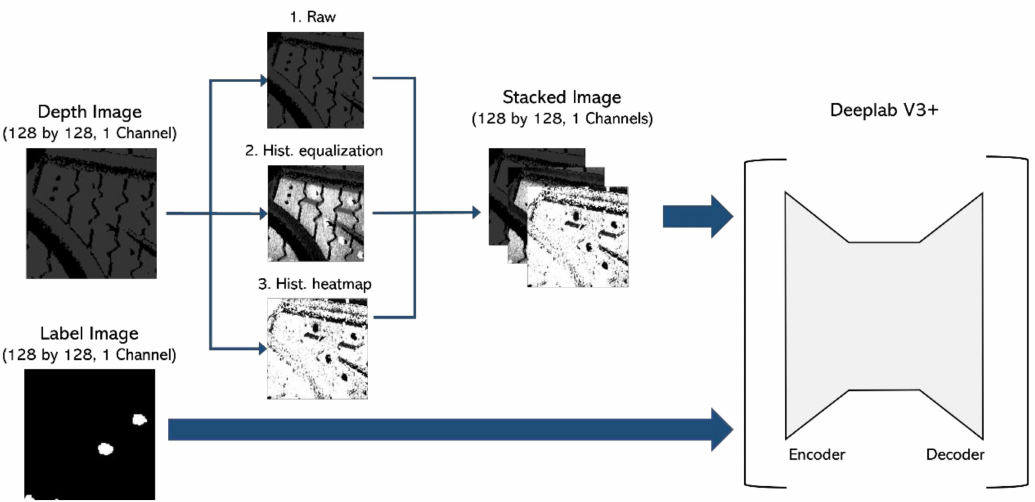
Figure 3. Proposed image preprocessing